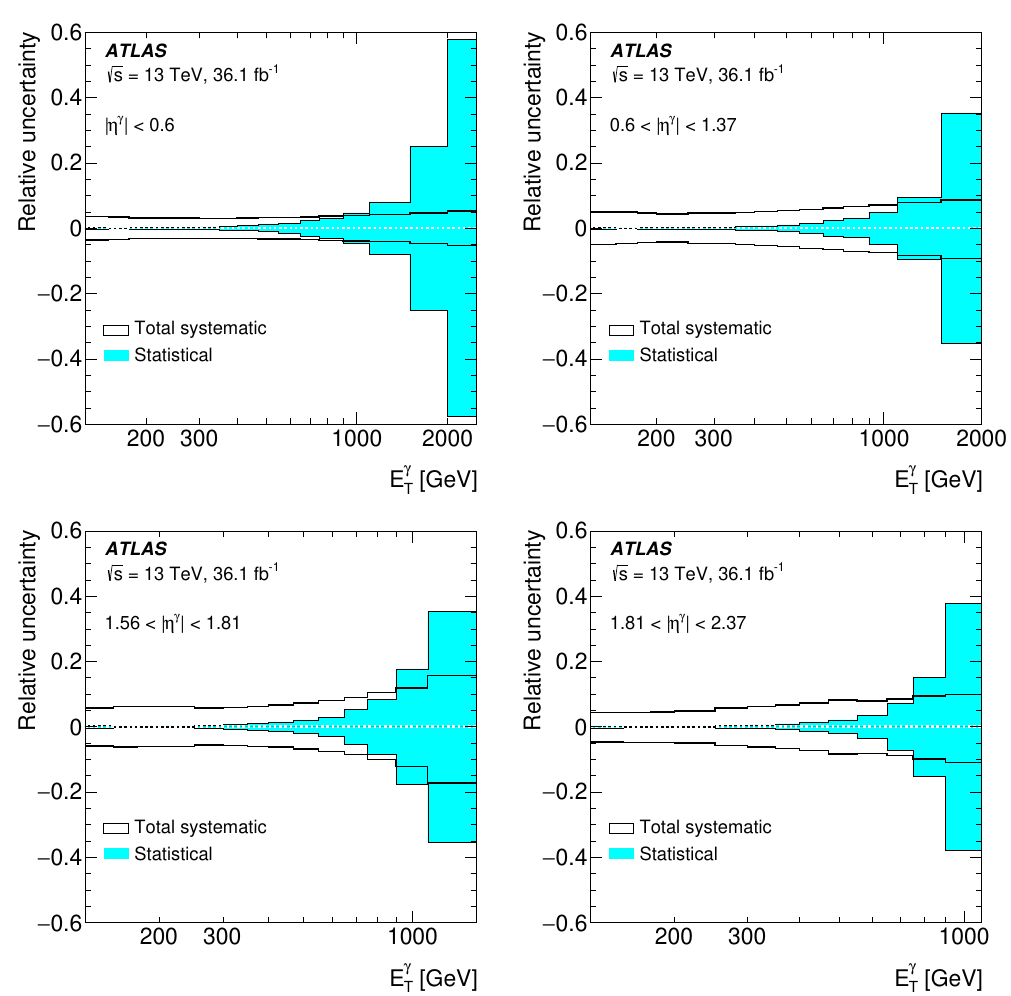
Figure 2 . The relative total systematic uncertainty in the cross section (white areas) as a function of E (cid:13) in di(cid:11)erent j (cid:17) (cid:13) j regions. The relative statistical uncertainty from the data is also shown T (cyan